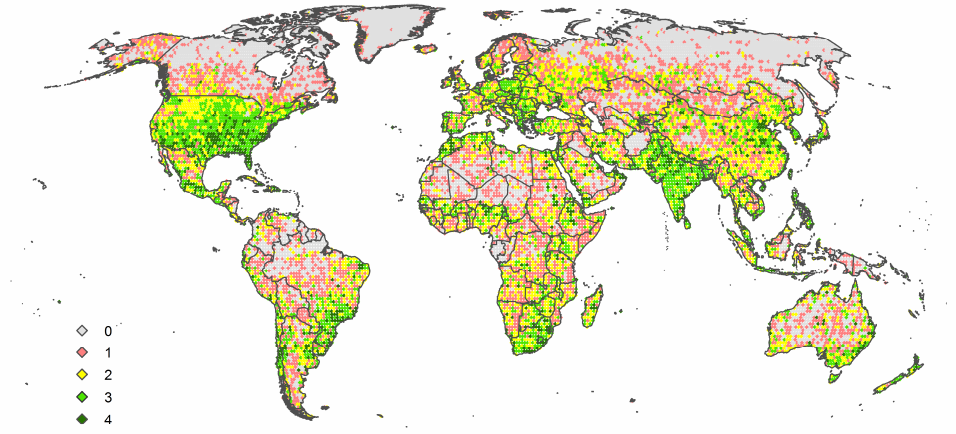
Figure 6. The availability of VHR imagery (<5 m) in Google Earth based on the number of seasons represented by the dates (Software: Esri ® ArcMap™